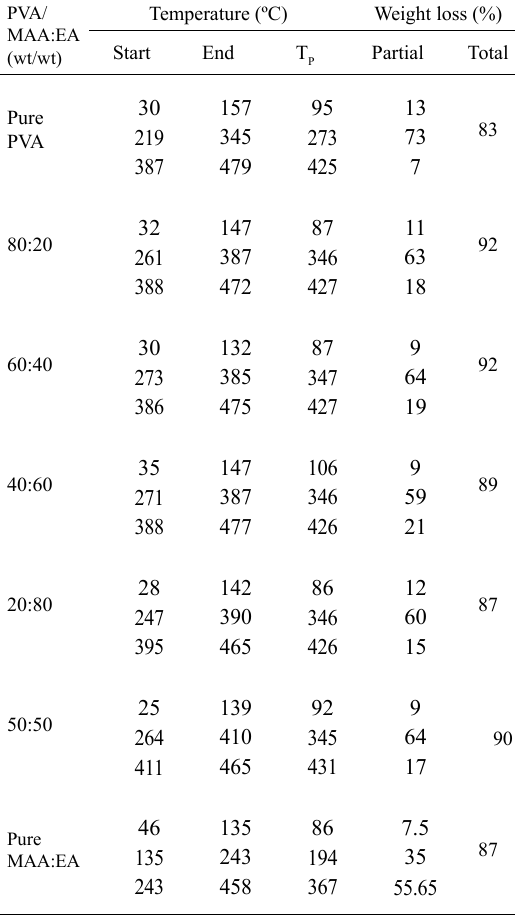
matrices. Figure 7 shows the X - ray diffraction patterns of PVA and MAA:EA copolymers as well as their blend samples at room temperature in the scanning range 0º≤2θ≤40º.